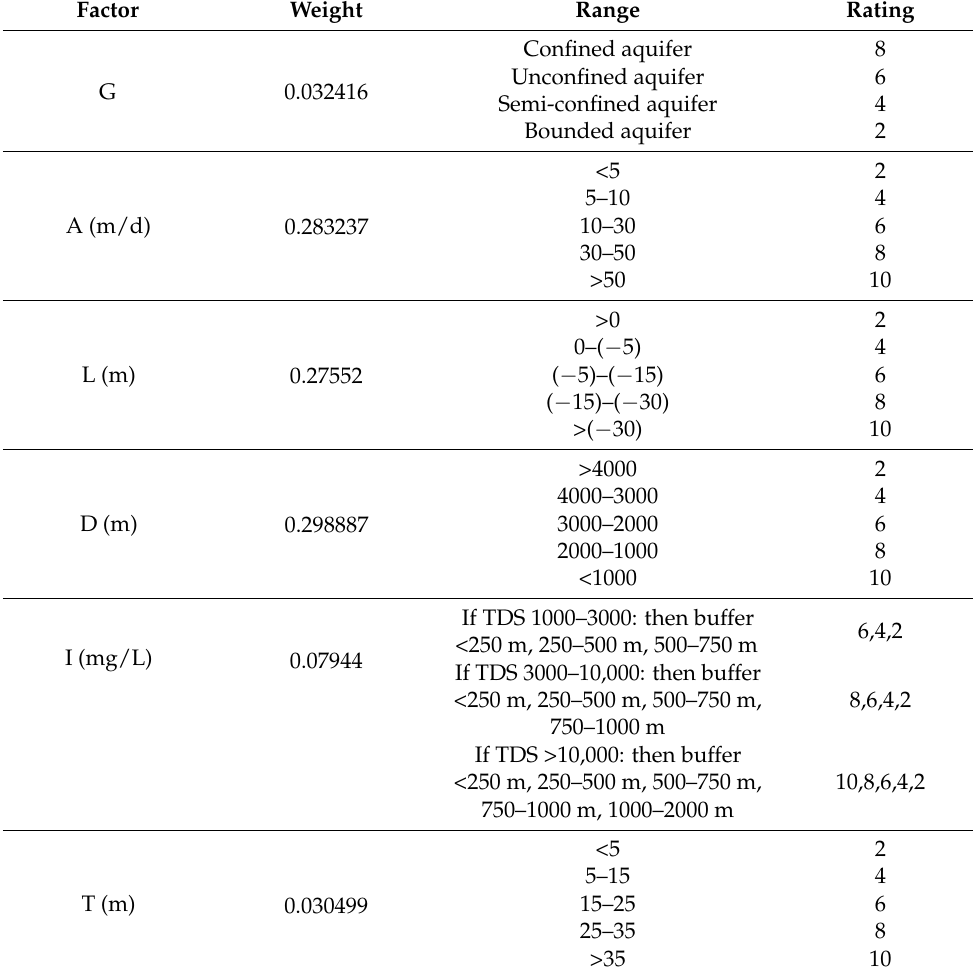
Table 3. Weights, ranges and rating of six factors for the modified GALDIT method.